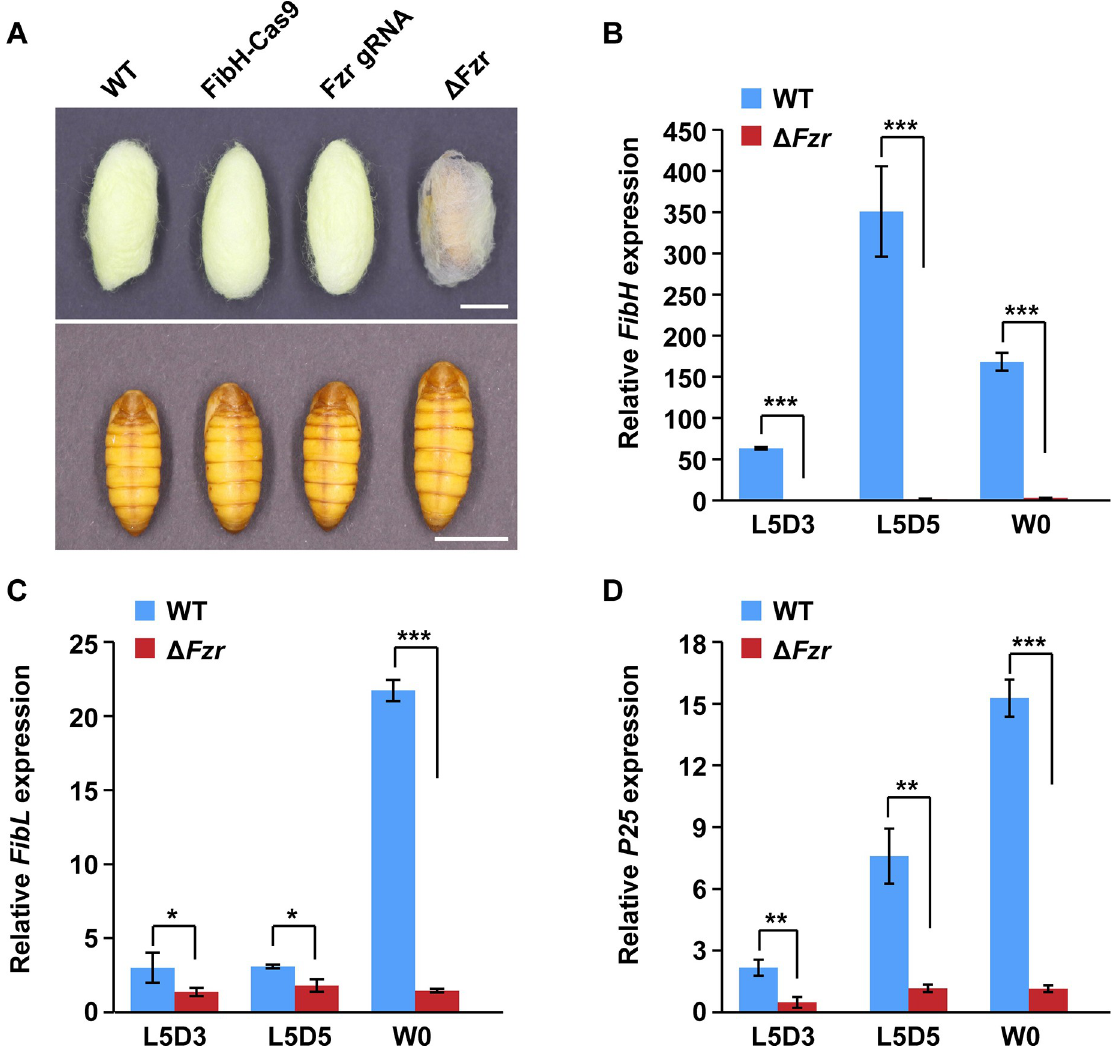
Fig 2. PSG-specific Fzr mutation decreases the expression of silk protein genes. (A) Fzr mutation in the PSG resulted in thinner cocoon compared with controls. ( B-D ) Fzr mutation in the PSG decreased the transcription of silk protein genes, including FibH (B), FibL (C), and P25 (D). Values were represented as means ± S.E. (error bars). For the significance test: � P < 0.05, �� P < 0.01, and ��� P < 0.001 versus the control. Scale bar, 1cm. WT, wild type. L5D3, the third day of the fifth larval instar; L5D5, the fifth day of the fifth larval instar; W0, just